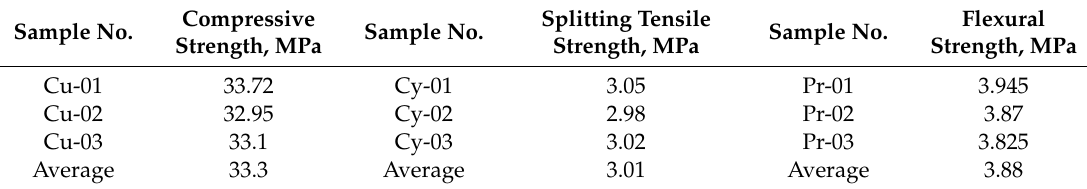
Table 2. Hardened concrete tests.